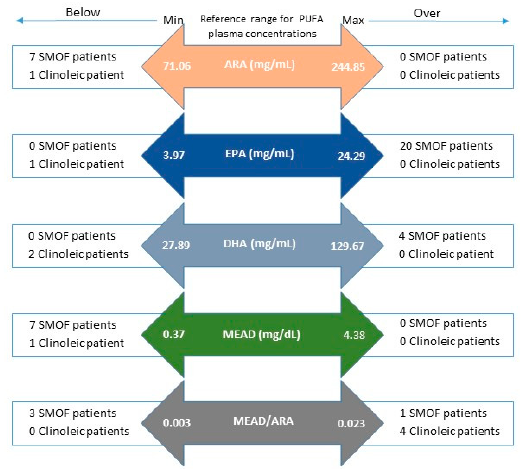
Figure 4. Number of patients on SMOF or Clinoleic having PUFA concentrations below or over the reference range for healthy children. ARA: arachidonic acid; EPA: eicosapentaenoic acid; DHA: docosahexaenoic acid; MEAD: eicosatrienoic acid.